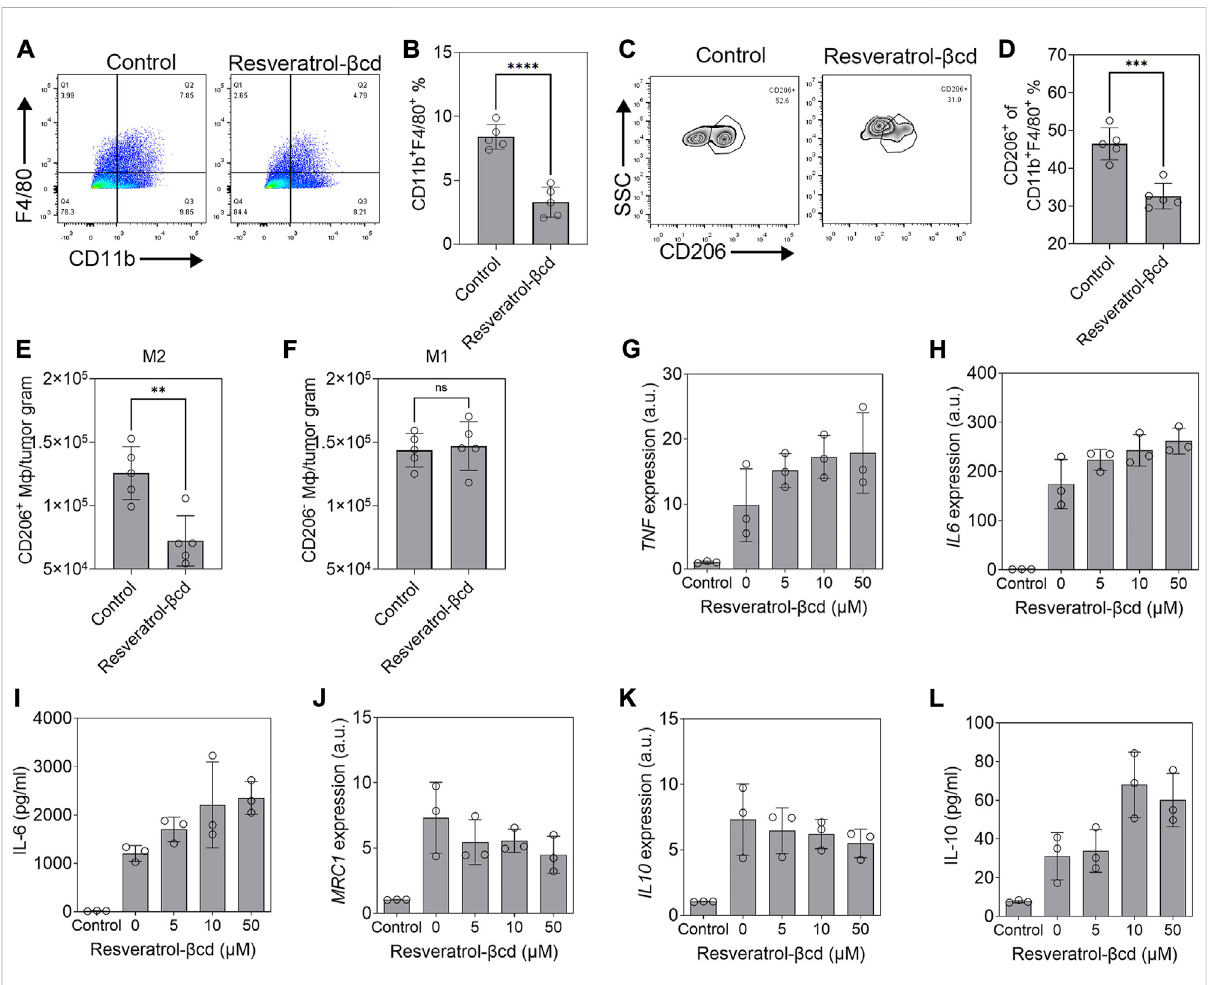
FIGURE 3 Resveratrol- β cd switch tumor-associated macrophage M2-type polarization. (A,C) Typical fl ow cytometry diagram of TAM (CD11b + F4/80 + ) or M2macrophages(CD11b + F4/80 + CD206 + ).ThecellswereCD45 + gated. (B,D) TheproportionsofTAMorM2-likemacrophagesinthetreatmentand control groups. Error bar = mean ± S.D. *** p < 0.001. **** p < 0.0001. (E) The numbers of M2-like and (F) M1-like (CD206 - F4/80 + CD11b + ) macrophagespertumorgram.** p < 0.01. (G) THP1asthecontrolgroupandTHP1-derivedM1macrophagestreatedwithresveratrol- β cdatthe indicated concentrations. TNF and (H) IL6 transcript levels and (I) IL-6 levels in the medium 48 h after treatment were measured to identify M1 polarization. Error bar = mean ± S.D. (J) MRC1 , (K) IL10 , and (L) IL-10 levels 48 h after treatment with the indicated concentration of resveratrol- β Cd. Error bar = mean ±